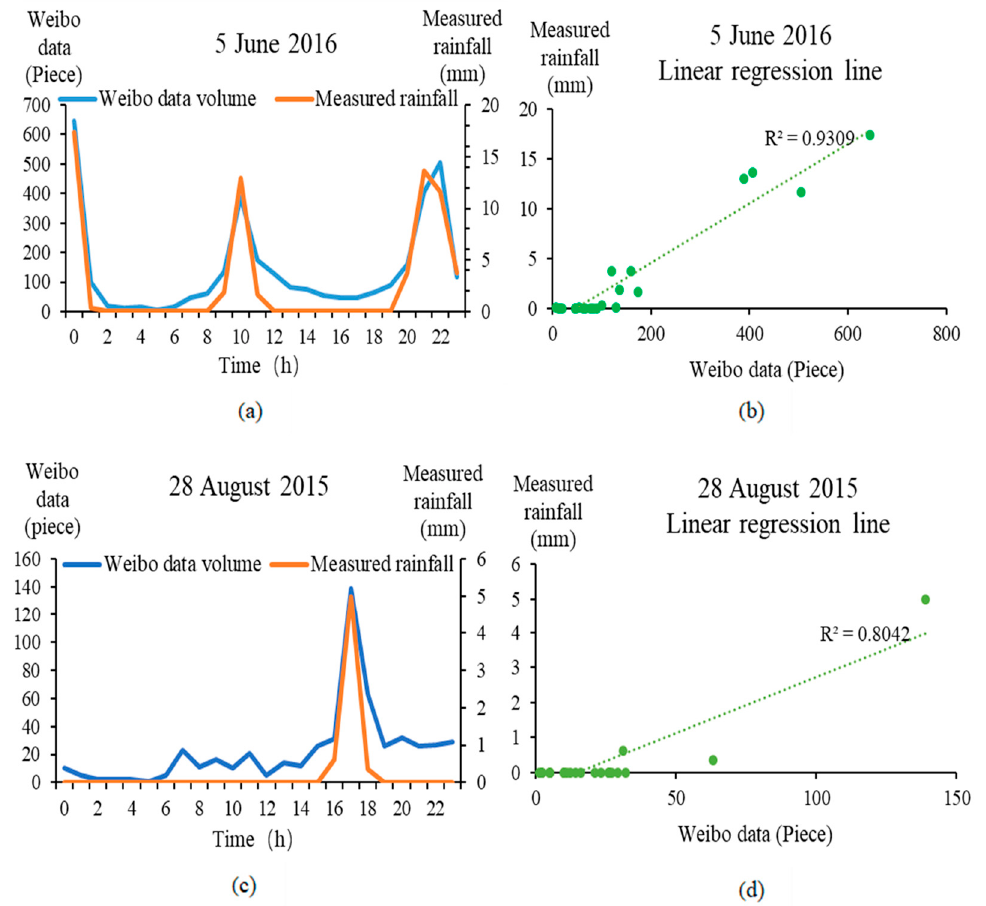
Figure 10. Comparison of two kinds of 24-h data process lines in Zhengzhou. ( a ) Process line drawn for the collected Weibo data and the measured rainfall data, during a rainfall event that occurred on 5 June 2016. ( b ) Linear regression line drawn for the Weibo data collected and the measured rainfall data, during a rainfall event that occurred on 5 June 2016. ( c ) Process line drawn for the collected Weibo data and the measured rainfall data, during a rainfall event that occurred on 28 August 2015. ( d ) Linear regression line drawn for the Weibo data collected and the measured rainfall data, during a rainfall event that occurred on 28 August 2015. The green circles indicate Weibo data and measured rainfall data.